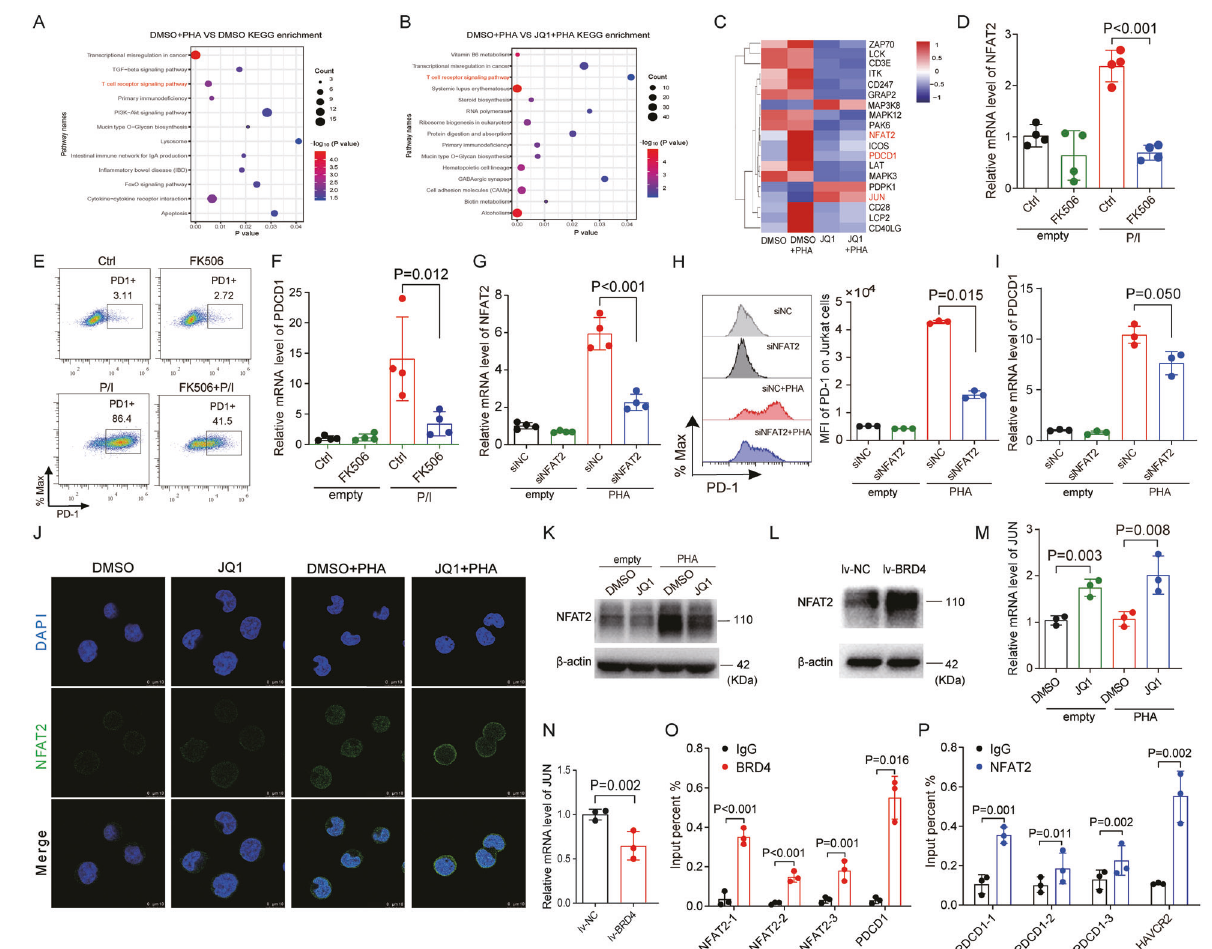
Fig. 5 BRD4 inhibition suppresses the expression of PD-1 and Tim-3 via NFAT2. A The top 12 enriched terms of the Kyoto Encyclopedia of Genes and Genomes (KEGG) enrichment pathway analyses were shown in the bubble plot (DMSO + PHA VS DMSO). The KEGG pathways was identi fi ed by R package “ clusterPro fi ler ” , and P < 0.05 was considered statistically signi fi cant. B Scatter plot of top 15 enriched KEGG pathways were shown in the bubble plot (DMSO + PHA VS JQ1 + PHA). C A heatmap of the expression of genes involved in the TCR signaling pathway in Jurkat cells was analyzed by RNA-seq. D CD8 + T cells were cultured with 100 ng/ml FK506 for 24 h in the presence and absence of P/I (PMA: 20 ng/L, ionomycin: 0.5 μ M), NFAT2 expression was determined by qRT-PCR ( n = 4). E PD-1 expression of CD8 + T cells treated with 100 ng/ml FK506 for 24 h in the presence and absence of P/I was determined by FACS ( n = 4). F PD-1 expression of CD8 + T cells treated with 100 ng/ml FK506 for 24 h in the presence and absence of P/I was determined by qRT-PCR ( n = 4). G Jurkat cells were stimulated with and without PHA (150 ng/mL) after NFAT2 knockdown, then qRT-PCR was used to examine the expression of NFAT2 ( n = 4). H PD-1 expression of Jurkat cells stimulated with and without PHA (150 ng/mL) after NFAT2 knockdown was determined by FACS ( n = 3). I PD-1 expression of Jurkat cells stimulated with and without PHA (150 ng/mL) after NFAT2 knockdown was determined by qRT-PCR ( n = 3). J Jurkat cells were treated with 0.5 μ M JQ1 for 24 h in the presence and absence of PHA (150 ng/mL), and NFAT2 expression was detected by immuno fl uorescence. K Jurkat cells were treated with 0.5 μ M JQ1 for 24 h in the presence and absence of PHA (150 ng/mL), and NFAT2 expression was detected by western blot. L NFAT2 expression was examined by western blot after overexpressing BRD4 in Jurkat cells. Shown are the representative images of three separate experiments. M Jurkat cells were treated with 0.5 μ M JQ1 for 24 h in the presence and absence of PHA (150 ng/mL), the expression of JUN was examined by qRT-PCR ( n = 3). N JUN expression was detected by qRT-PCR after BRD4 overexpression in Jurkat cells ( n = 3). O Chromatin samples from Jurkat cells stimulated with 150 ng/ml PHA for 24 h were immunoprecipitated with anti-BRD4 antibody, and enrichment of BRD4 at the promoter regions of NFAT2 and PDCD1 was measured by qRT-PCR ( n = 3). P The chromatin samples were stimulated with 150 ng/ml PHA for 24 h and immunoprecipitated with an anti-NFAT2 antibody, enrichment of NFAT2 at the promoter regions of PDCD1 and HAVCR2 was measured by qRT-PCR ( n = 3). Data are expressed as mean ± SD. n = 3 or more independent biological replicates, presented as individual points. P value < 0.05 was considered to be signi fi cant ( D , F – I , M , O , P : one-way ANOVA with Bonferroni post hoc test; N : two-tailed unpaired Student ’ s t